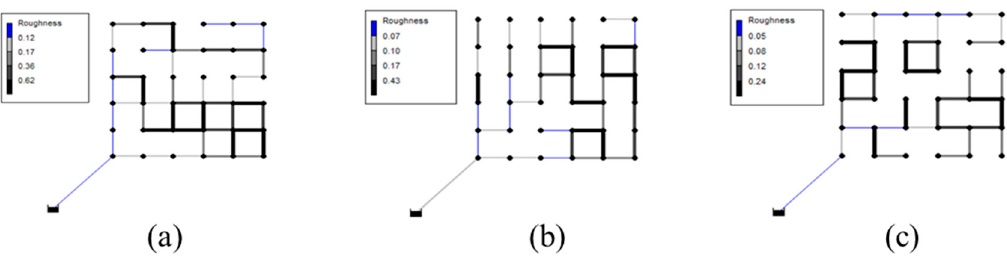
Figure 5. Variance of the pipe diameters in the final solutions: ( a ) BI = 0.2, MC = 0.4; ( b ) BI = 0.41, MC = 0.2; and ( c ) BI = 0.46, MC = 0.1. Thicker pipes have greater pipe diameter variance.